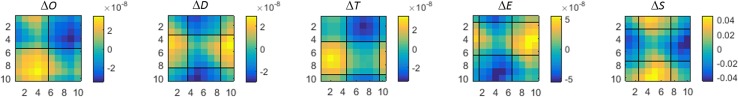
Intrinsic transition flux for subjects in the non-breast-cancer group.Intrinsic transition flux [i.e., average change, per transition, in concentration (units are moles-L-1) or saturation (units are %); computed using Eq (6)] results for the control-group subjects. Graphed data are averages over the left and right breasts. Headings denote the Hb components as indicated in Table 1. Thin solid lines separate regions according to the algebraic signs of the pre-and post-transition Hb-component values (see Fig 2).